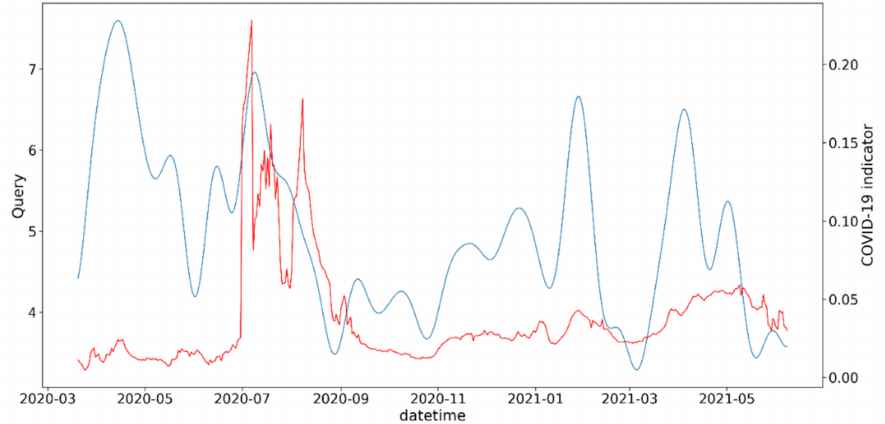
Figure A12. COVID-19—Positive rate. Query—vaccination COVID-19